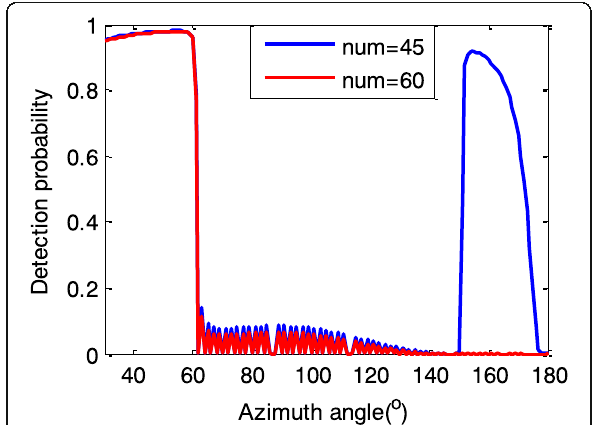
Fig. 14 Detection probability changes with different azimuth